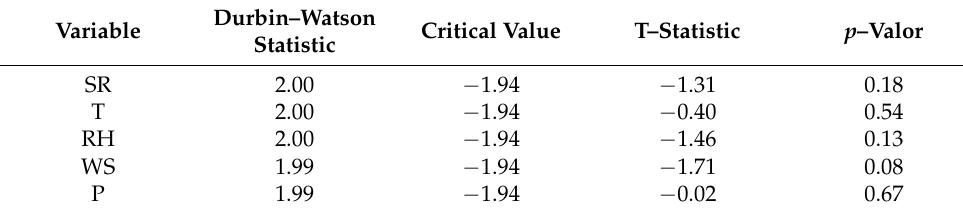
Table 2. ADF test results (significance test 5%).